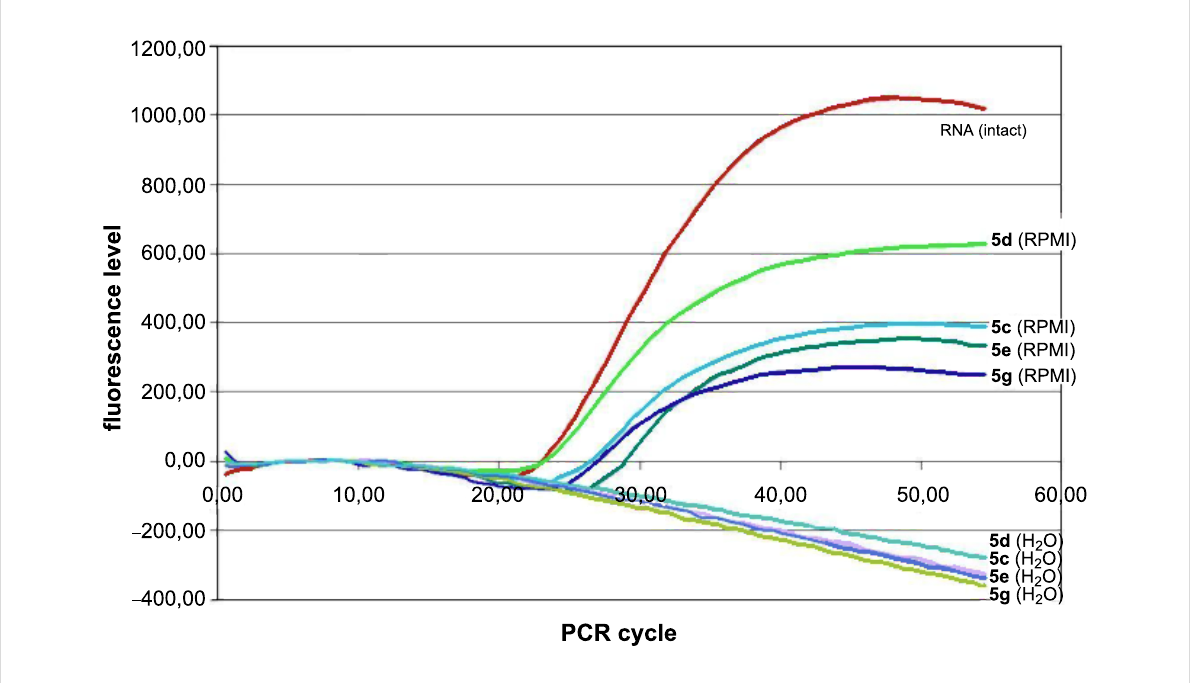
Figure 3: Results of RT-qPCR of the TBEV RNA cleavage products in the presence of 2.5 mM peptidomimetics after incubation in H 2 O and in cultural medium RPMI 1640.